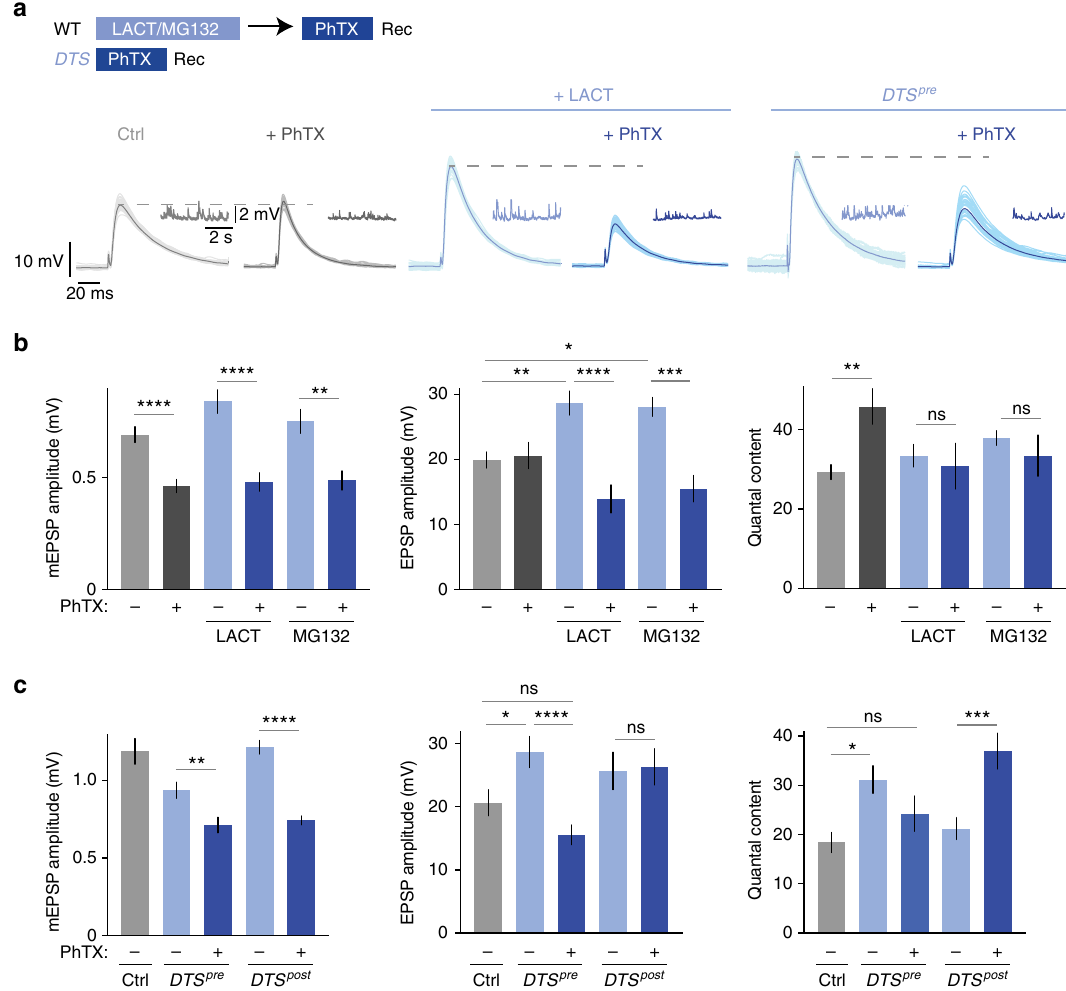
Fig. 1 Presynaptic proteasome perturbation blocks presynaptic homeostatic plasticity. a Scheme for treatment of NMJs and representative EPSP and mEPSP traces (Rec: recording). Wild-type NMJs were incubated with saline, 100 µ M lactacystin for 15 min or 50 µ M MG-132 for 15 min, followed by wash and treatment with saline or 20 µ M PhTX for 10 min at 0.3 mM [Ca 2+ ] e . DTS -mutant synapses were treated with saline or 20 µ M PhTX for 10 min at 0.3 mM [Ca 2+ ] e . A total of 30 sweeps are shown per cell, with the average displayed in darker color. b Quanti fi cation of mEPSP amplitude, EPSP amplitude and quantal content for wild-type synapses treated as described in ( a ). PhTX treatment induced an increase in quantal content (right). Note that PhTX application after lactacystin or MG-132 treatment completely blocks the homeostatic increase in quantal content (right). Mean ± s.e.m.; n ≥ 6 cells; * p < 0.05; ** p < 0.001; *** p < 0.0001; **** p < 0.00001; ns: not signi fi cant; ANOVA and Tukey ’ s multiple comparison tests for comparison of EPSP amplitudes, Student ’ s t -test for pairwise comparison of mEPSP amplitude and quantal content in PhTX-treated vs. non-PhTX-treated cells. c Quanti fi cation of mEPSP amplitude, EPSP amplitude and quantal content of control synapses ( elav C155 -Gal4 and 24B-Gal4 ) and synapses expressing mutant proteasome subunits presynaptically ( elav C155 -Gal4;UAS-DTS5/ + ;UAS-DTS7/ + ; ‘ DTS pre ’ ) or postsynaptically ( UAS-DTS5/ + ;UAS-DTS7/24B-Gal4 ; ‘ DTS post ’ ). Synapses were treated with 20 µ M PhTX or saline for 10 min at 0.3 mM [Ca 2+ ] e . Note that there is no increase in quantal content upon PhTX treatment after genetic presynaptic proteasome perturbation ( DTS pre ), indicating a defect in presynaptic homeostatic plasticity. PhTX treatment after postsynaptic proteasome perturbation potentiates quantal content (right), demonstrating that postsynaptic proteasome mutants do not have a defect in homeostatic